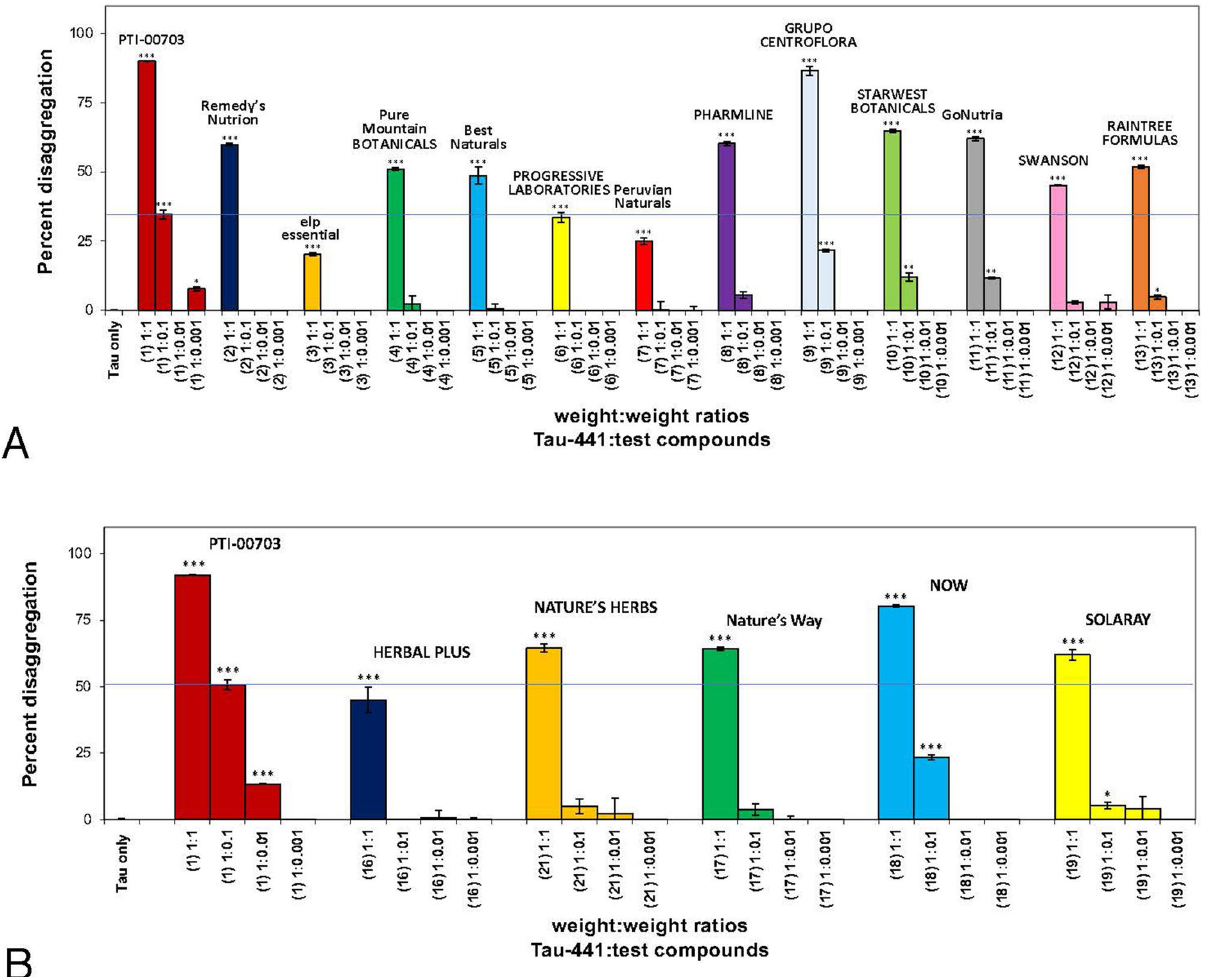
1:0.1 wt/wt dose of tau protein: PTI-00703 Cat’s claw significantly disaggregated tau protein tangles by 34.3%. Cat’s claw extract from GRUPO CENTROFLORA was the closest to the robust activity demonstrated by PTI- 00703 Cat’s claw with only 20.2% disaggregation shown at the 1:0.1 wt/wt dose. *p < 0.05, **p < 0.01, ***p < 0.001, by Student’s t-test. Bars represent mean ± SEM. ( B ) Comparisons of PTI-00703 Cat’s claw to 5 other cat’s